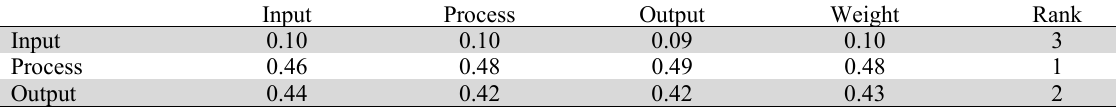
Normalized Matrix and weight of factor production to goal EG Input Process Output